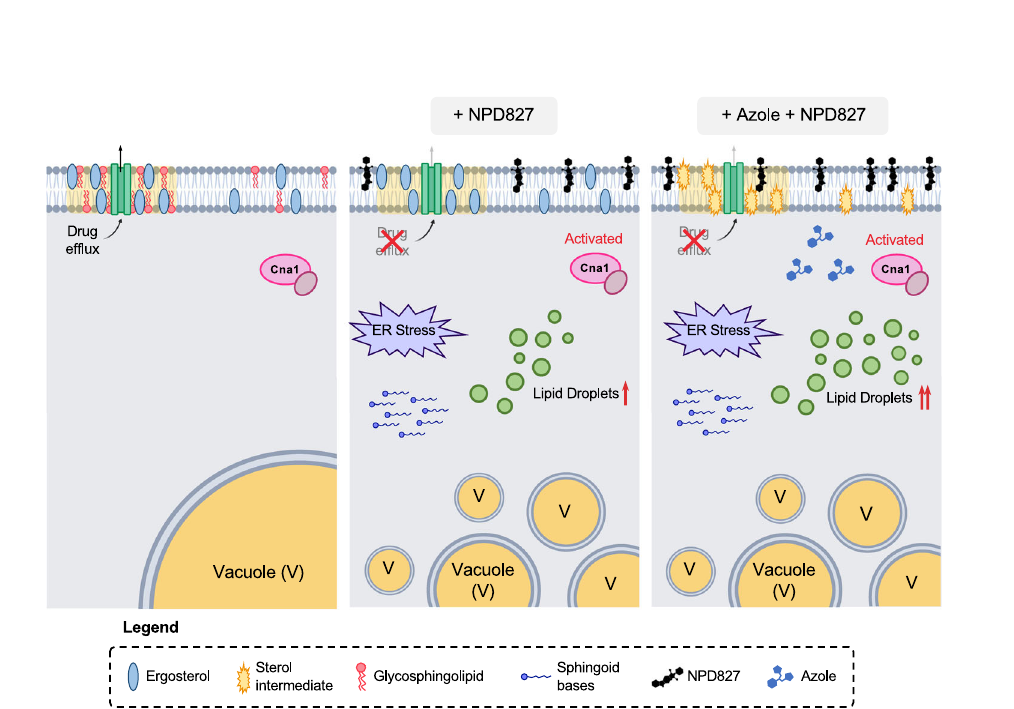
Serial dilutions of catheter fl uid were plated for fungal colony counts. Data represented as mean colony forming unit (CFU) per catheter ±SD of three technical replicates. Signi fi cance determined by a two-tailed unpaired t -test with Welch ’ s correction, p -value: *<0.05. p -value: 0.0071 (NPD827). Source data are provided as a Source Data fi le.